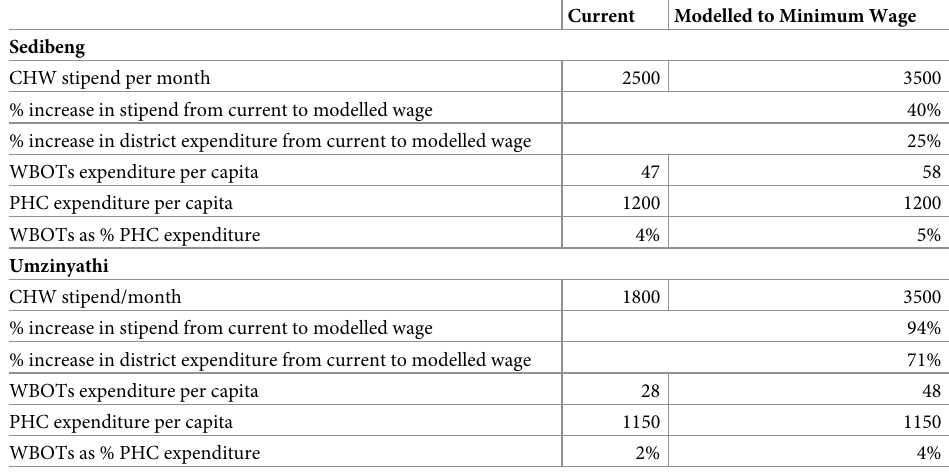
Table 10. Financial impact of CHW stipend increase to national minimum